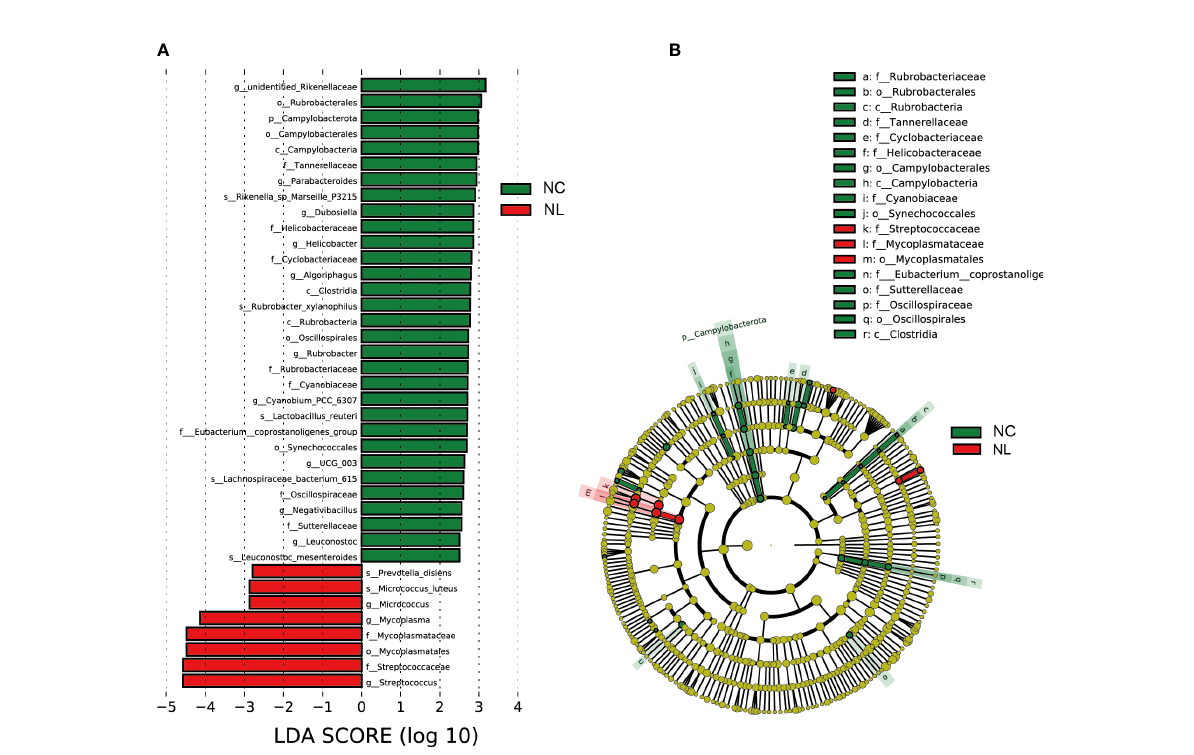
FIGURE 2 Urinary microbiome differential analysis. (A) Difference in abundance estimated by linear discriminant analysis effect size (LEfSe) between the normal control (NC) and nephrolith (NL) groups. (B) Taxonomic cladogram presenting phylogenetic distribution of microbiota related to NC and NL groups. Threshold of linear discriminant analysis (LDA) greater than 2.5 are